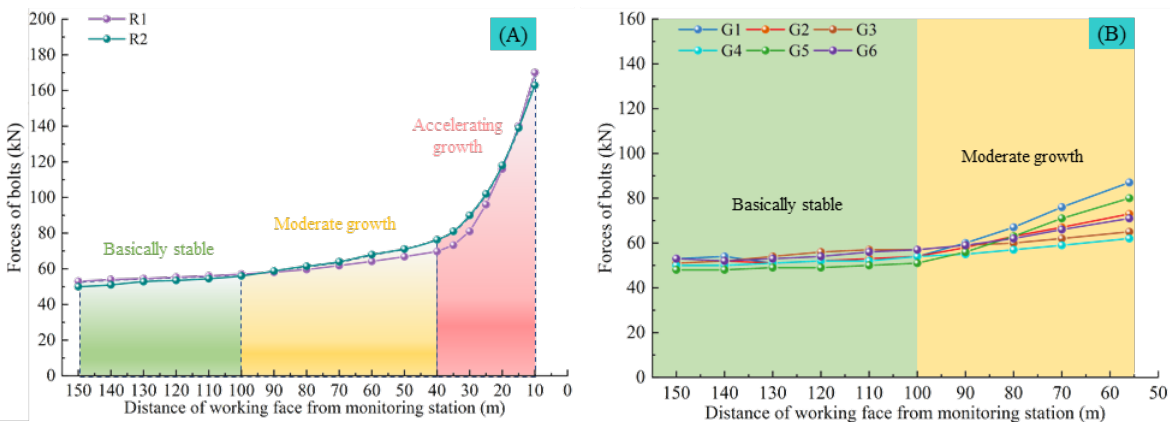
Figure 20. Anchor bolts stress meter monitoring results. ( A ) The main haulage roadway. ( B ) The main return-air roadway.